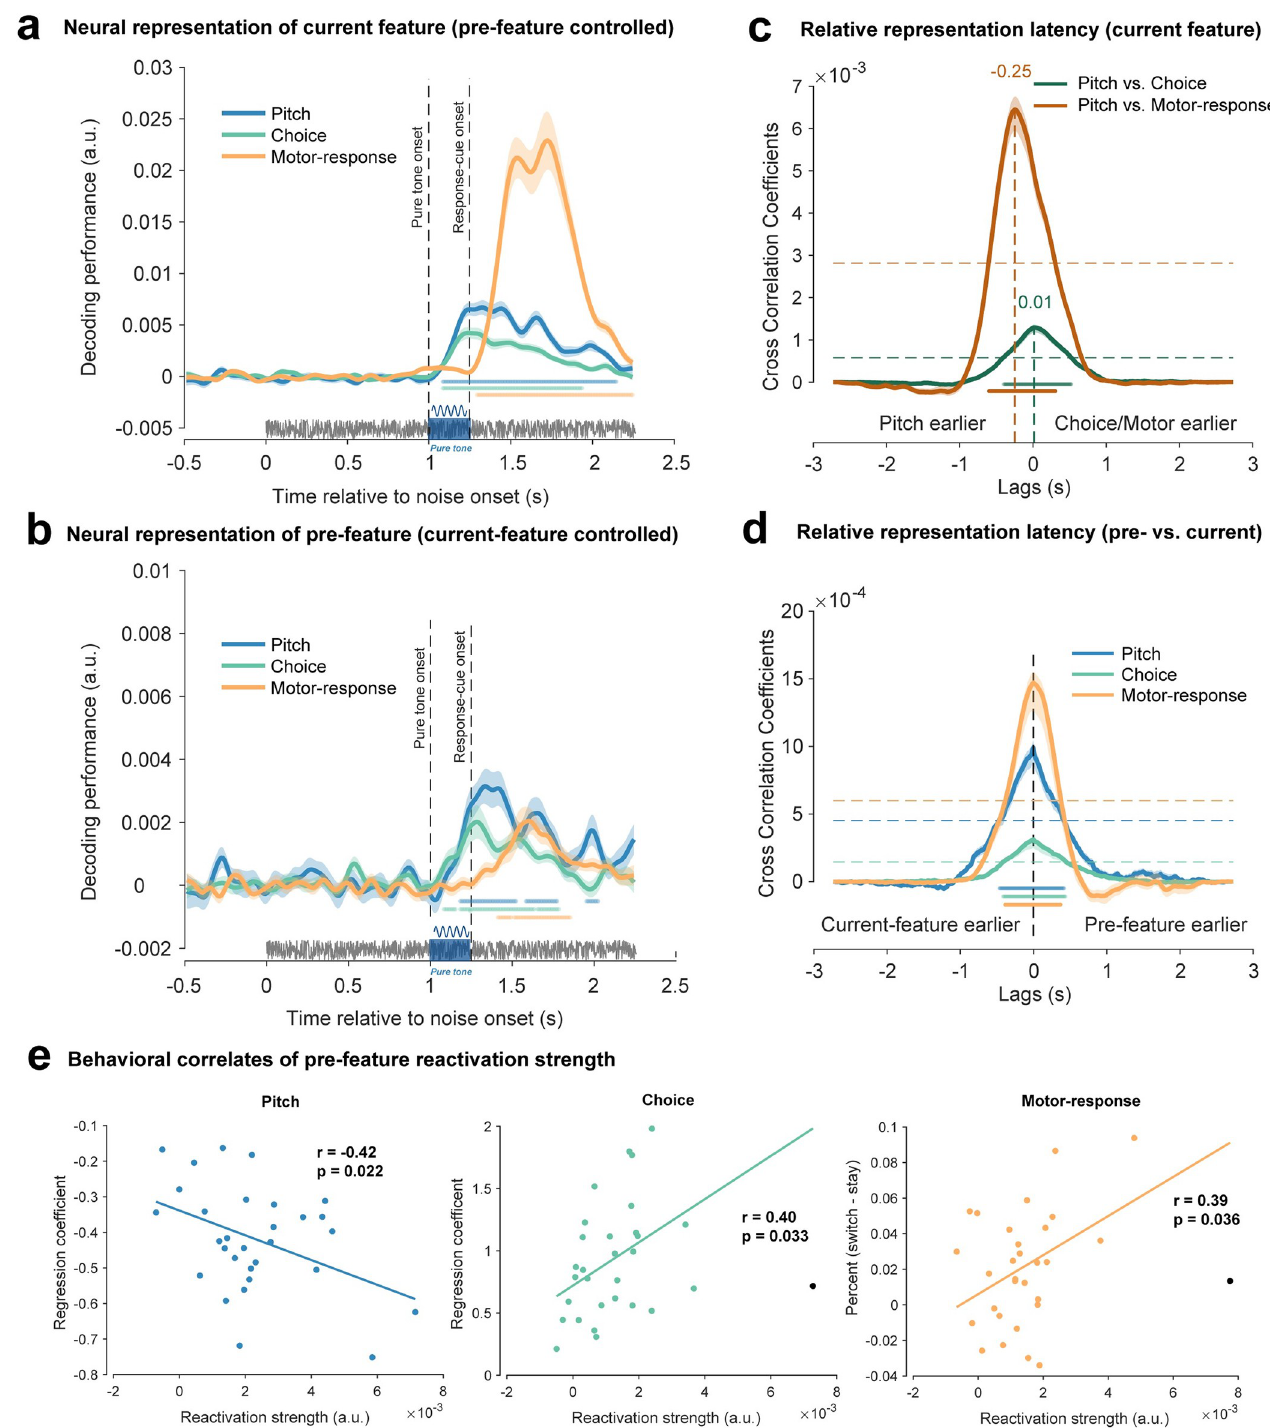
Fig 2. Co-occurrence of past-trial neural reactivations and neural encoding of current-trial features. (A) Grand average decoding performance for current- trial features as a function of time following the sustained white noise, for pitch (blue), category choice (green), and motor response (orange). The pure tone (blue rectangle) was embedded in a 2.25-s sustained white noise (grey horizontal line). Vertical dashed lines from left to right denote the tone onset and response cue frame, respectively. Horizontal colored lines denote significant temporal clusters (cluster-based permutation test, p < 0.001, one-sided, corrected) for each feature. Shadows represent SEM. ( B ). The same as A but for past-trial features. Note that the past-trial decoding is performed by fixing the current-trial feature. ( C ). Cross-correlation coefficients as a function of temporal lag for each current-trial feature pair (green: pitch vs. category; brown: pitch vs. motor